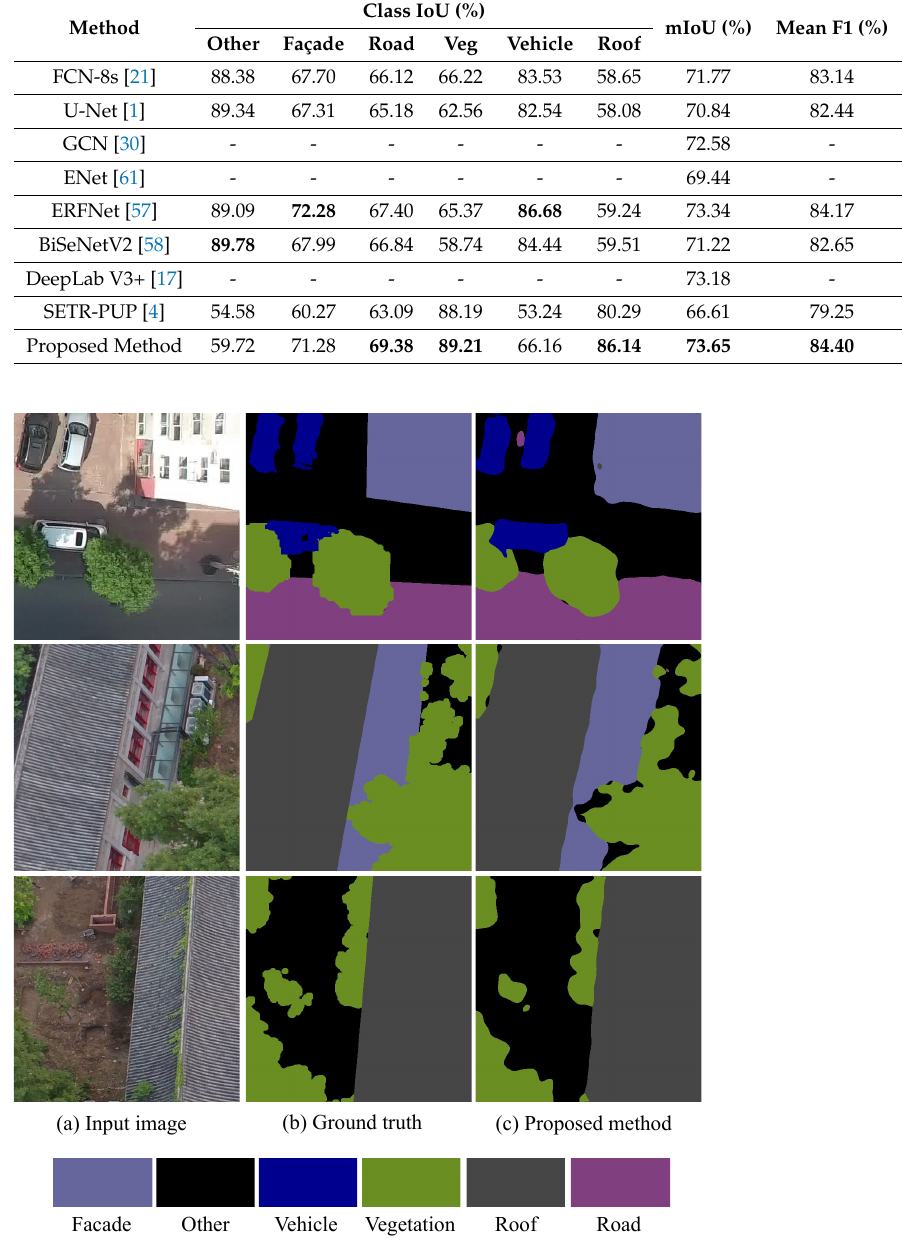
Figure 6. Qualitative prediction results using the UDD-6 validation